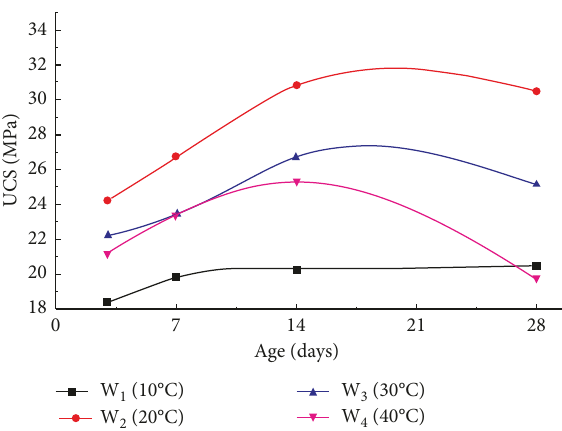
Figure 7: Compressive strength of different